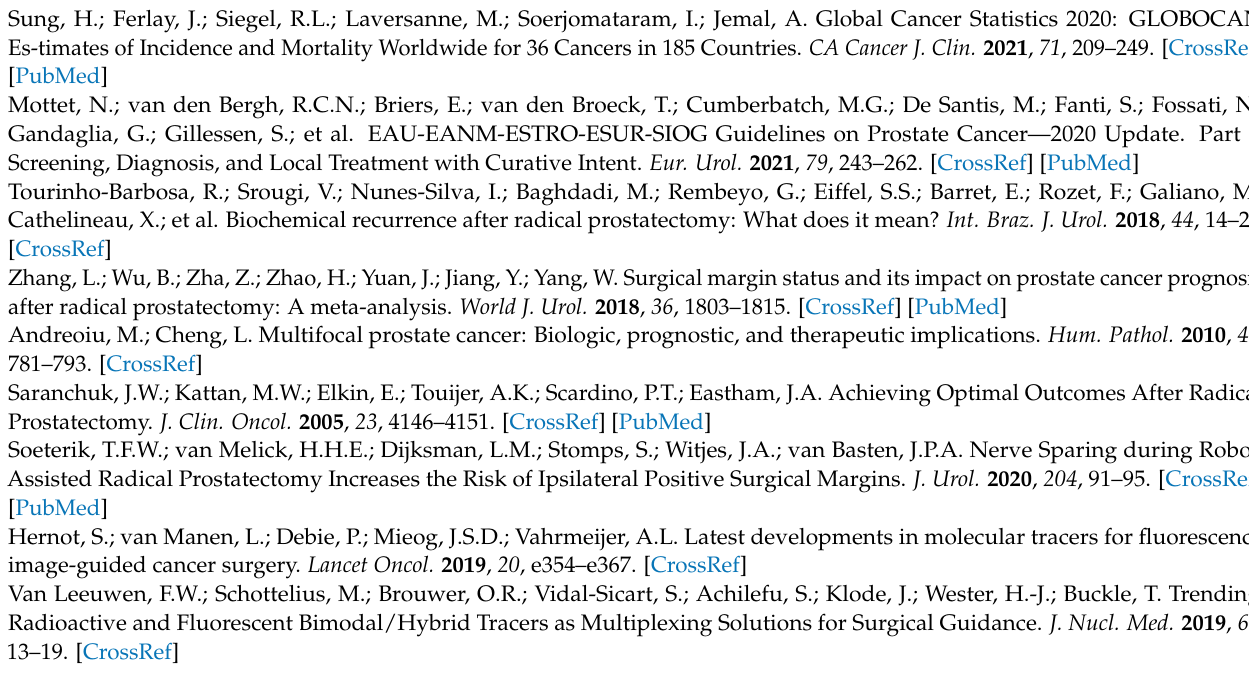
Figure S1: Inhibition of [ 111 In]In-NeoB binding to PC-3 cells with probes 10, 11, 12, 13, 14, 15 and NeoB (as positive control), Table S1: Biodistribution of [ 111 In]In- 12 and [ 111 In]In- 15 in PC-3 xenograft Balb/c nu/nu mice after SPECT/CT scanning, Table S2: Fluorescent signal of [ 111 In]In- 12